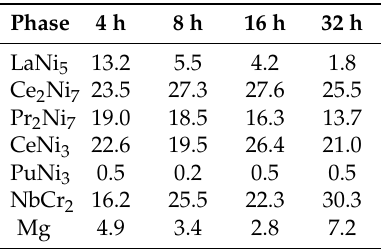
Table 2. Phase abundances (in wt %) obtained by EBSD mapping of the 4-h, 8-h, 16-h, and 32-h annealed samples with a grain tolerance angle of 5 ◦ and a minimum grain size of 2 µ m.